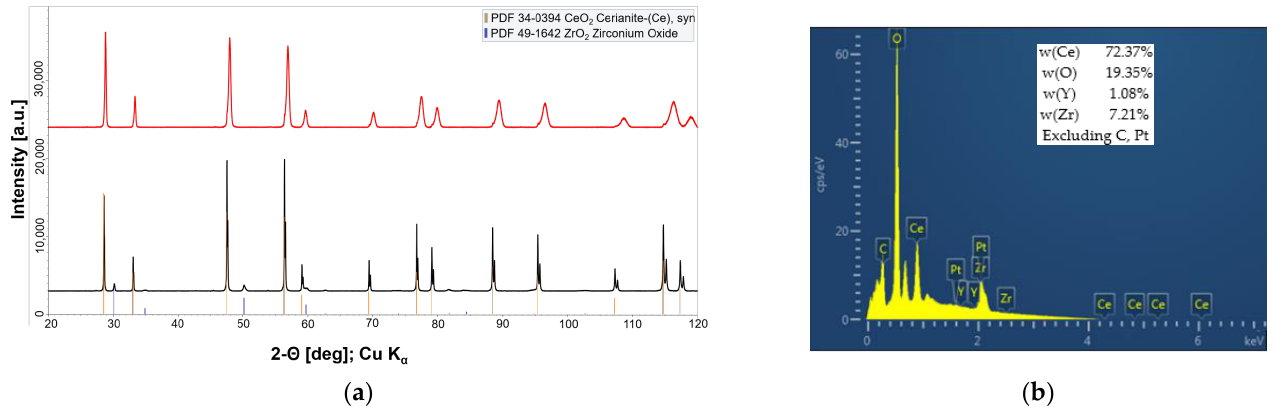
Figure 4. ( a ) XRD-profile of the CeO 2 /YSZ felt mixture after heat treatment at 1573 K (black) and 1923 K (red). ( b ) EDS results of the CeO 2 /YSZ felt mixture after heat treatment at 1923 K.